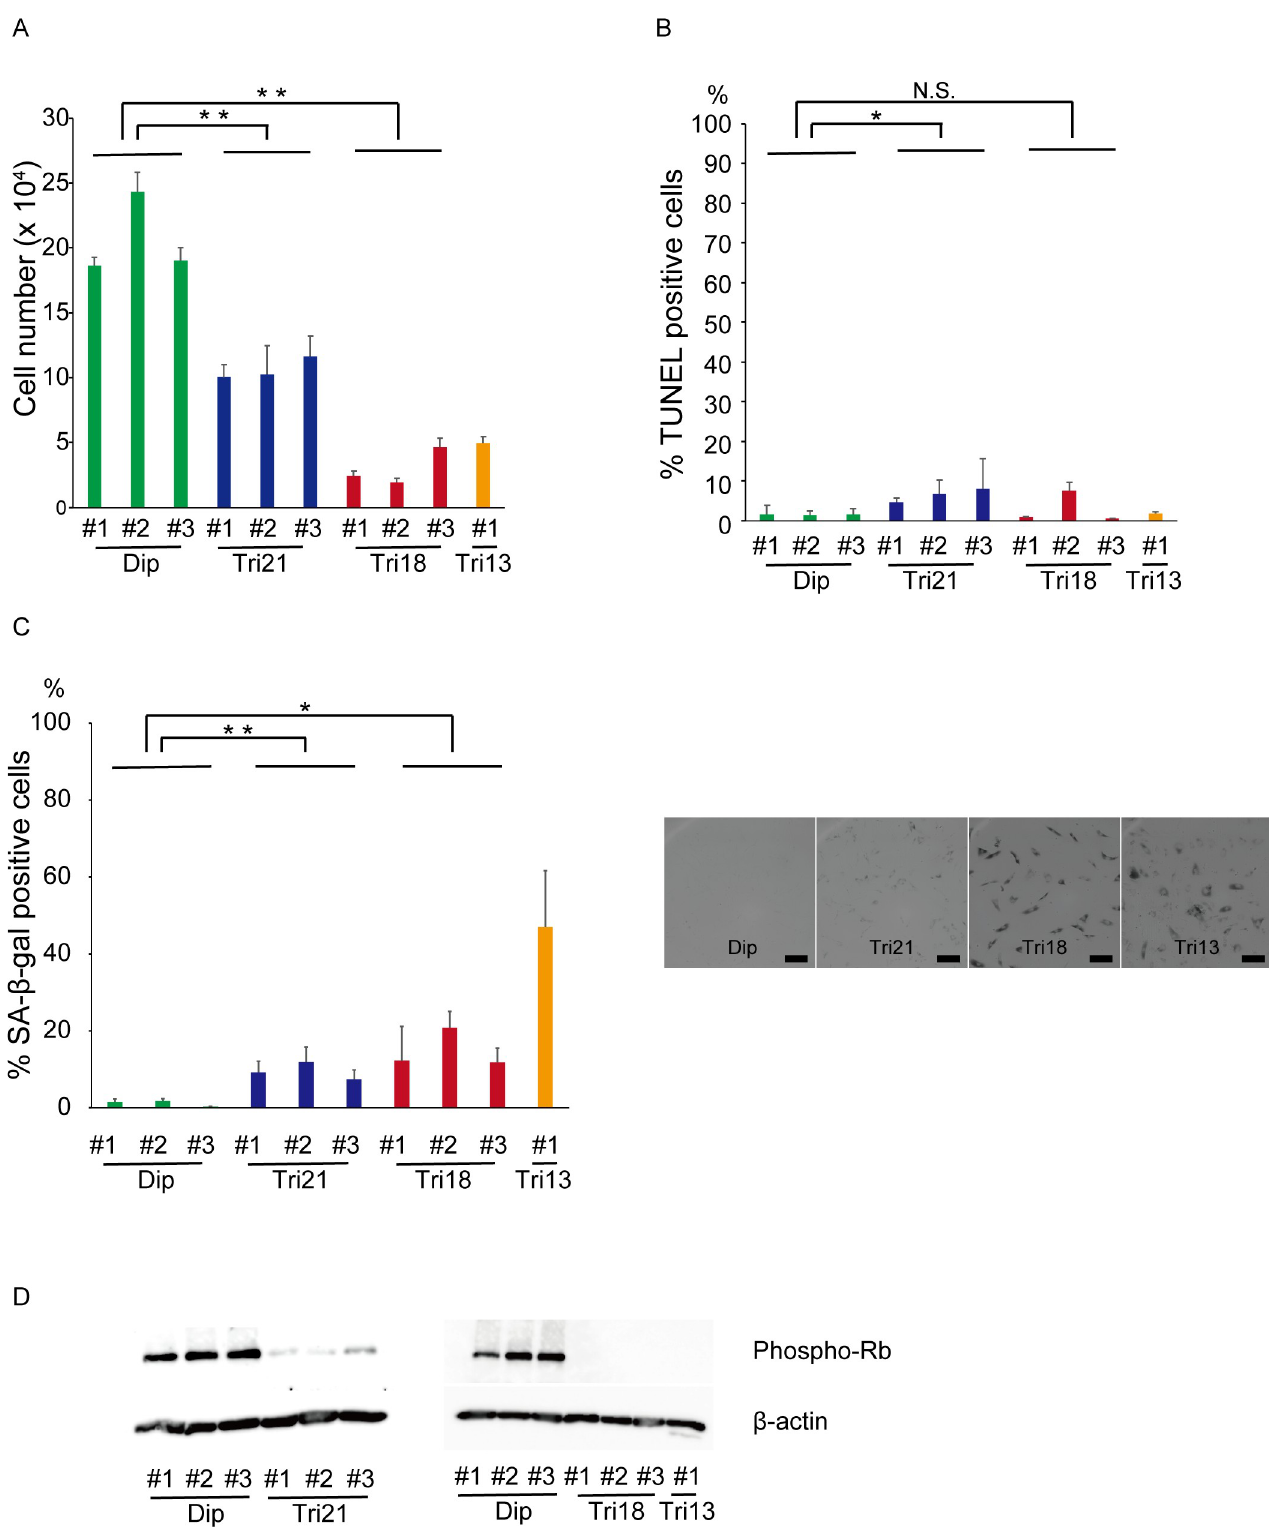
Fig 1. Trisomy fibroblasts showed severe proliferative impairment owing to premature senescence. (A) Absolute cell numbers three days after seeding 3 × 10 4 cells (n = 3 per cell line). �� P < 0.01. Dip, diploid; Tri, trisomy. (B) Percentage of TUNEL-positive cells (n = 3–7 per cell line). � P < 0.05. Dip, diploid; Tri,